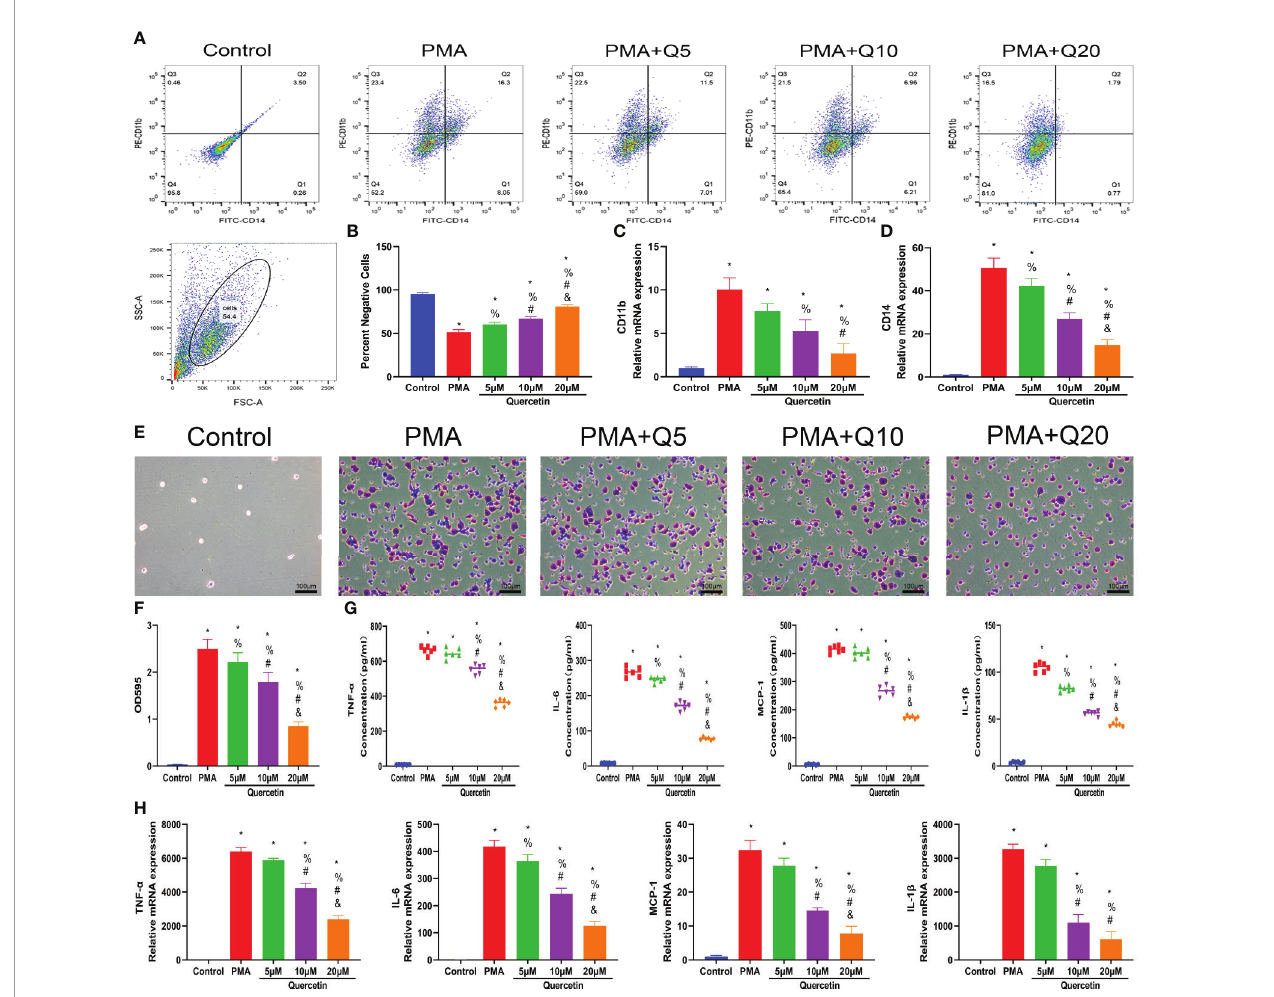
FIGURE 4 | Quercetin inhibited the monocyte-to-macrophage transition in vitro . THP-1 cells were pretreated with quercetin for 1 h and then incubated with PMA for 48 h. (A) Flow cytometry analysis for CD14 and CD11b. (B) Bar graphs illustrating the percentage of CD14 and CD11b double-negative cells. (C, D) The relative gene expression of CD11b and CD14 was determined using qRT-PCR. (E) Crystal violet staining of transitioned macrophages from THP-1 cells. (F) OD595 value of eluted crystal violet staining. (G) In fl ammatory cytokine secretion during the monocyte-to-macrophage transition was examined by ELISA. THP-1 cells were pretreated with quercetin for 1 h and then incubated with PMA for 24 h. (H) The relative gene expression of in fl ammatory cytokines was tested by qRT-PCR. *P < 0.05 compared with the control group, % P < 0.05 compared with the PMA group, # P < 0.05 compared with the 5 m M group, & P < 0.05 compared with the 10 m M